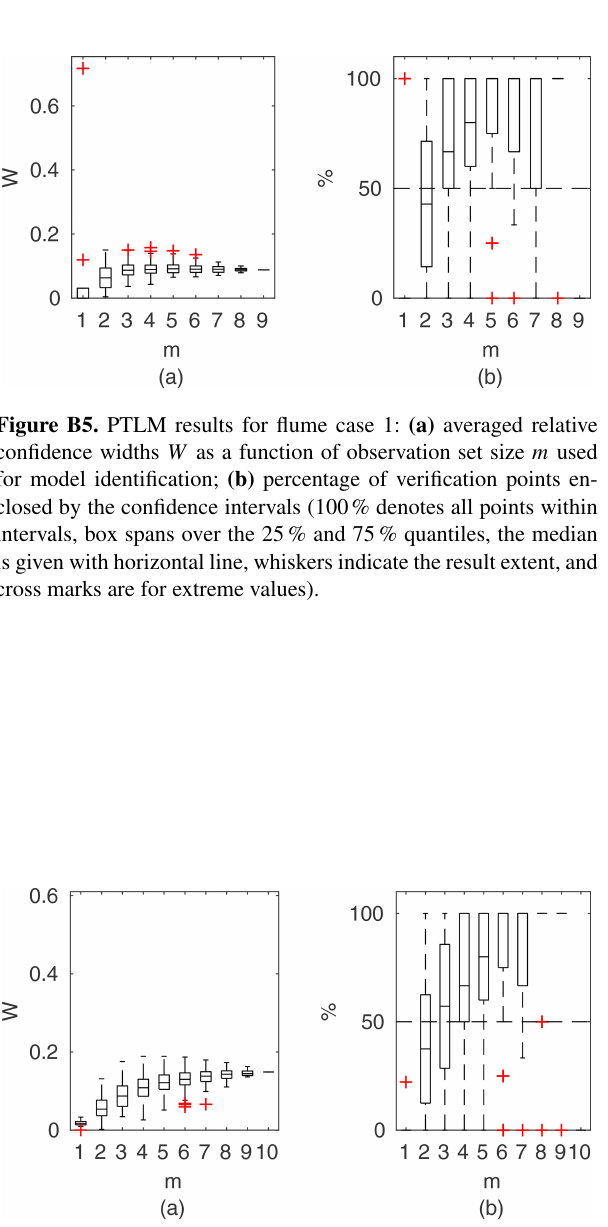
Figure B8. Mertens results for flume case 1: (a) averaged relative confidence widths W as a function of observation set size m used for model identification; (b) percentage of verification points en- closed by the confidence intervals (100% denotes all points within intervals, box spans over the 25% and 75% quantiles, the median is given with horizontal line, whiskers indicate the result extent, and cross marks are for extreme